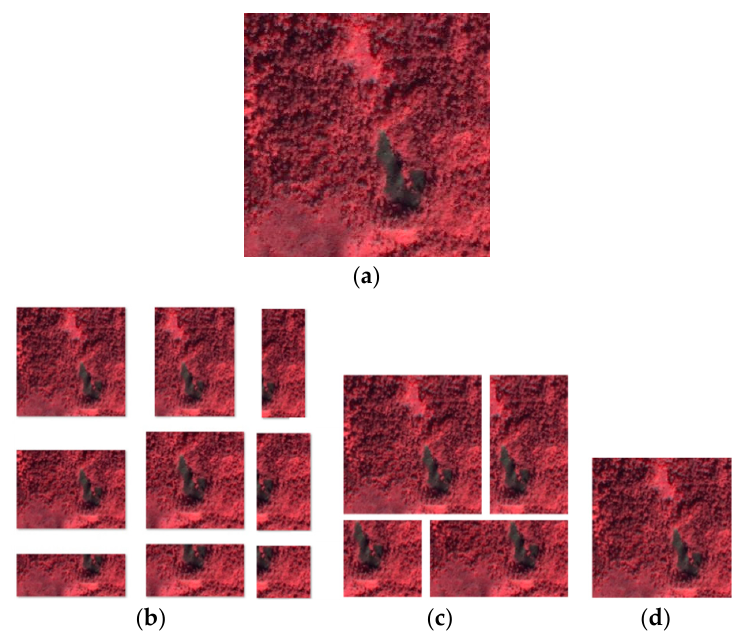
Figure 20. Training sample images showing the effect of the overlap. ( a ) The original image measuring 320 × 317; ( b – d ) the different samples when the overlap is 100, 150, and 200. For every ground truth target, the small overlap setting can generate many samples with different backgrounds, which increases the diversity of the training samples. More samples often improve the performance of the deep learning model. In this study, we only conducted three comparative experiments for different overlaps. If we had set the overlap smaller, more samples would have been generated, which may improve the model performance or not. In future work, we will explore how the overlap influences the model performance, as well as whether setting it to smallest (value =1) is the optimal choice.